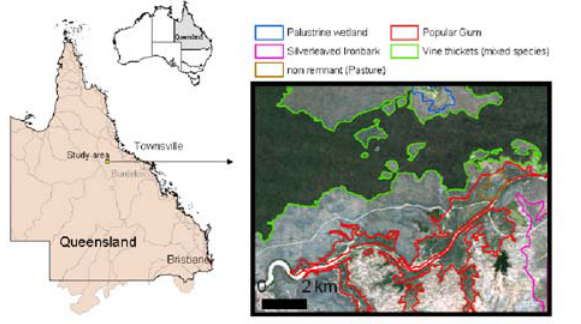
Figure 1. Study area in a Landsat true color composite, superimposed is a subset of the regional ecosystem classification.